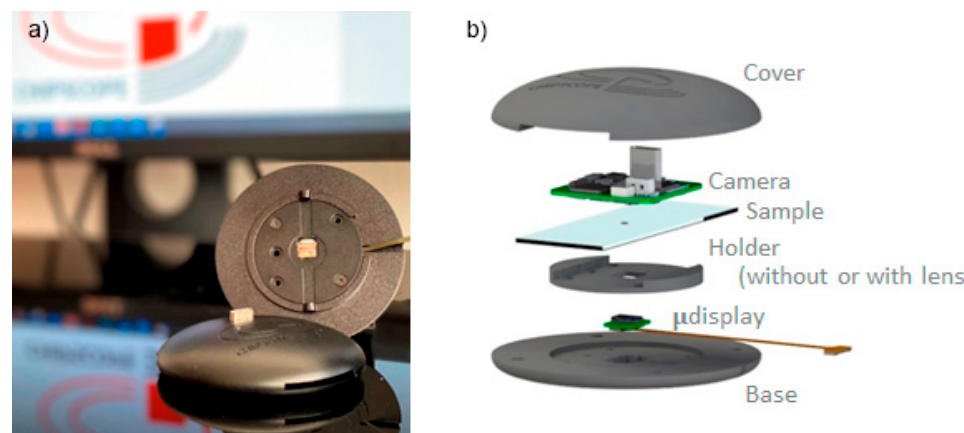
Figure 2. Appearance ( a ) and deployment ( b ) of the proposed e-STOM: inside the oval box there is a detector ( up ), the sample and its holder ( middle ) and a microdisplay ( bottom ). A lens can be located below the sample. Note that the microscope dimension is only limited by microdisplay and detector sizes, and its observation chamber just needs to fit sample and lens, if used.